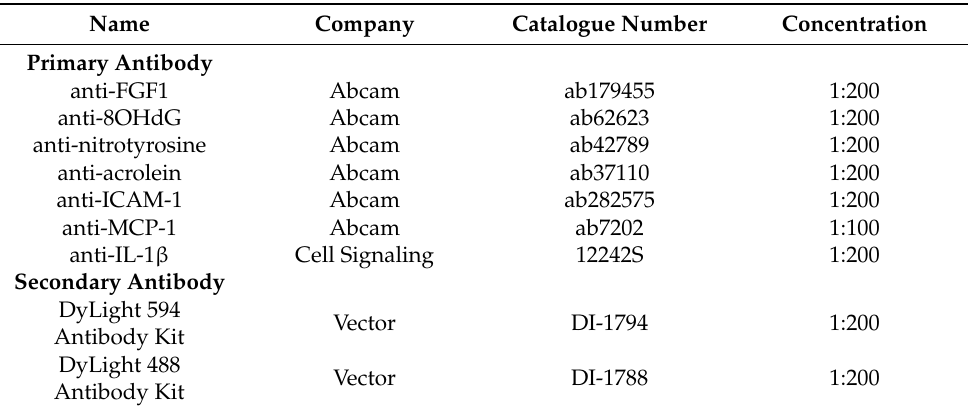
Table 1. List of IF primary and secondary